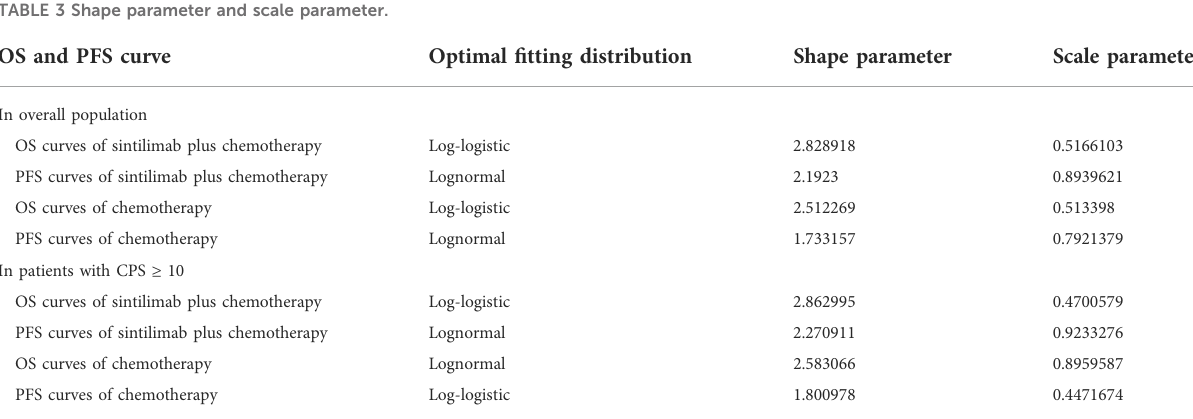
TABLE 3 Shape parameter and scale